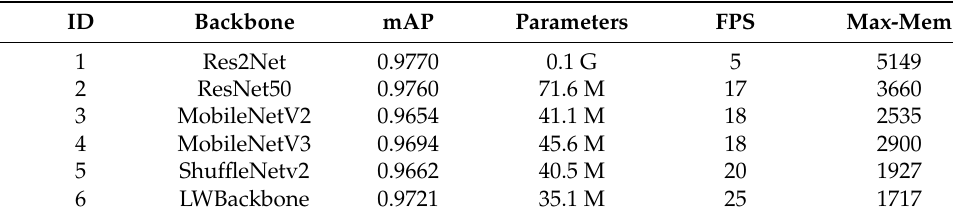
Table 2. Comparison of different backbones.